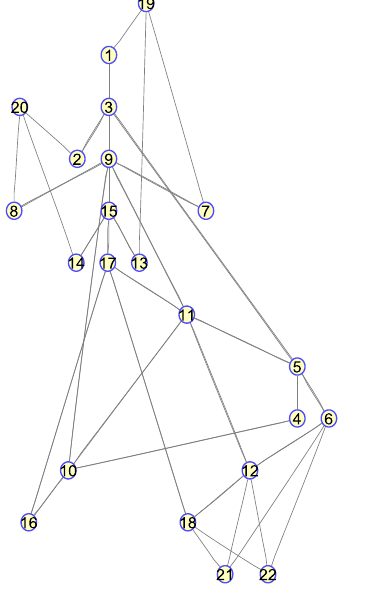
Figure 2. Graph corresponding to the extended TEG in Figure.1